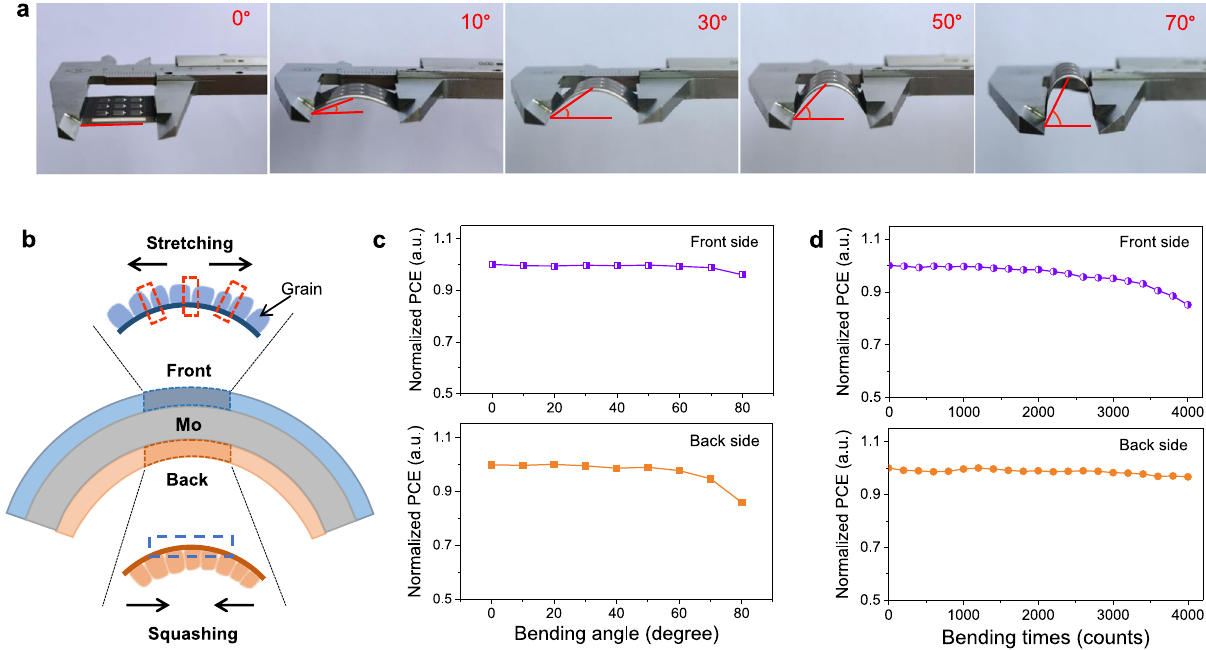
Fig. 5 Flexible performance of bifacial CZTSSe solar cells. a Photographs of bended bifacial CZTSSe solar cells at varied angles from 0° to 70°. b Schematic bending states with stretching and squashing of front and back sides. c Normalized PCE degradation percent of bifacial solar cells at different angles (0° – 80°) with 100 time bending. d Normalized PCE degradation evolution with different bending cycles (0 – 4000 times) at a fi xed angle of 50°.